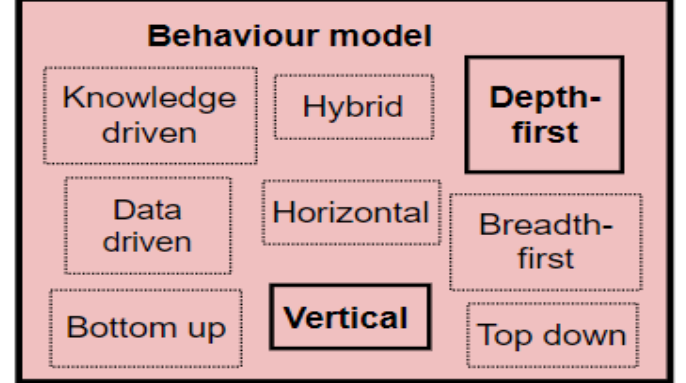
Figure 5. The Expanded Behavioural Model component.